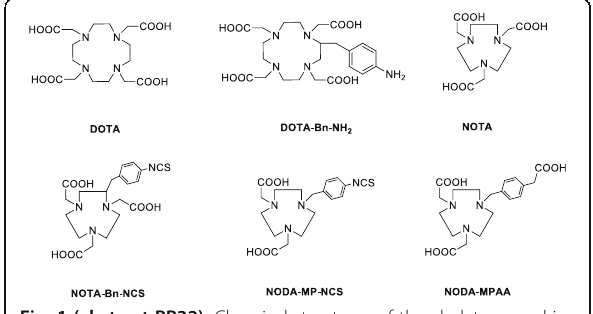
Fig. 1 (abstract PP32). Chemical structures of the chelators used in this